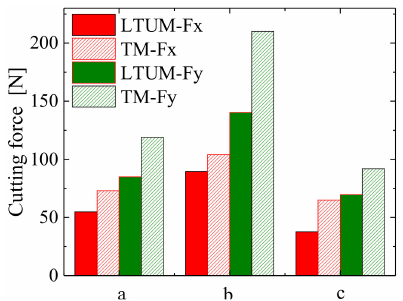
Figure 11. Cutting force comparison of LTUM and TM.